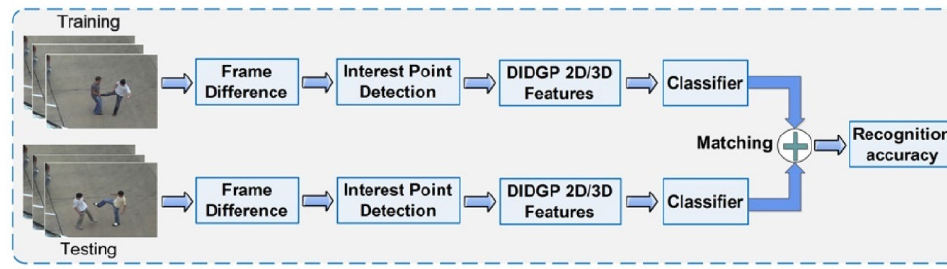
Figure 2. Overview of the proposed method.